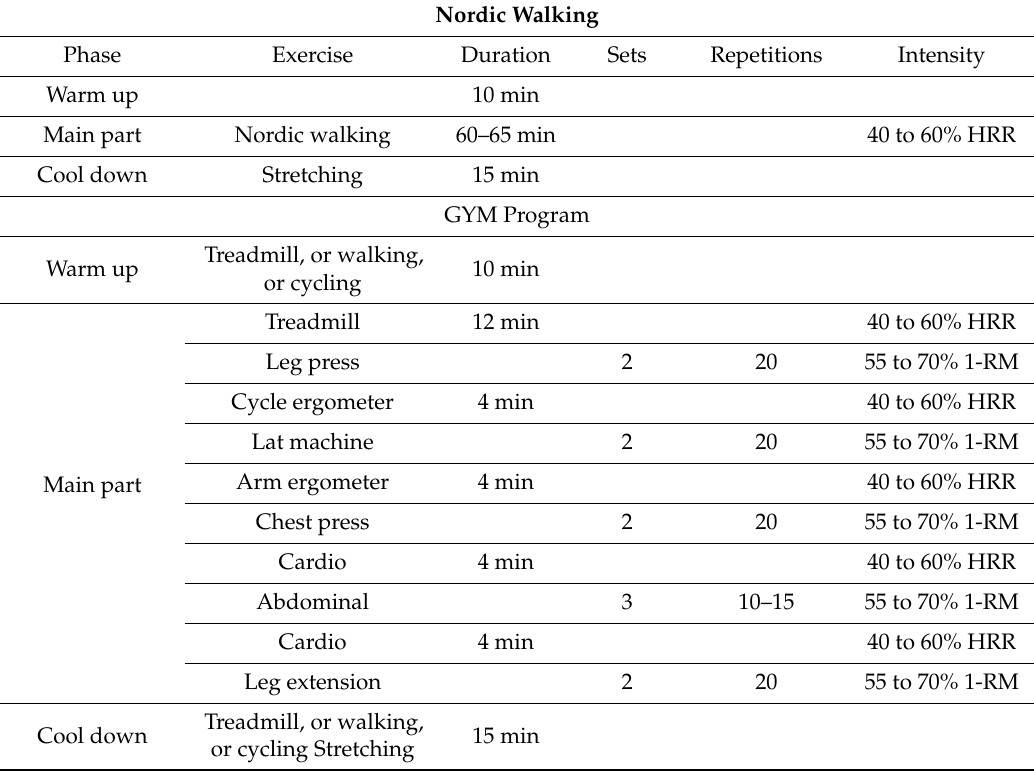
Table 2. Exercises for both Nordic walking (NW) program and gym-based exercise program (GYM). Nordic